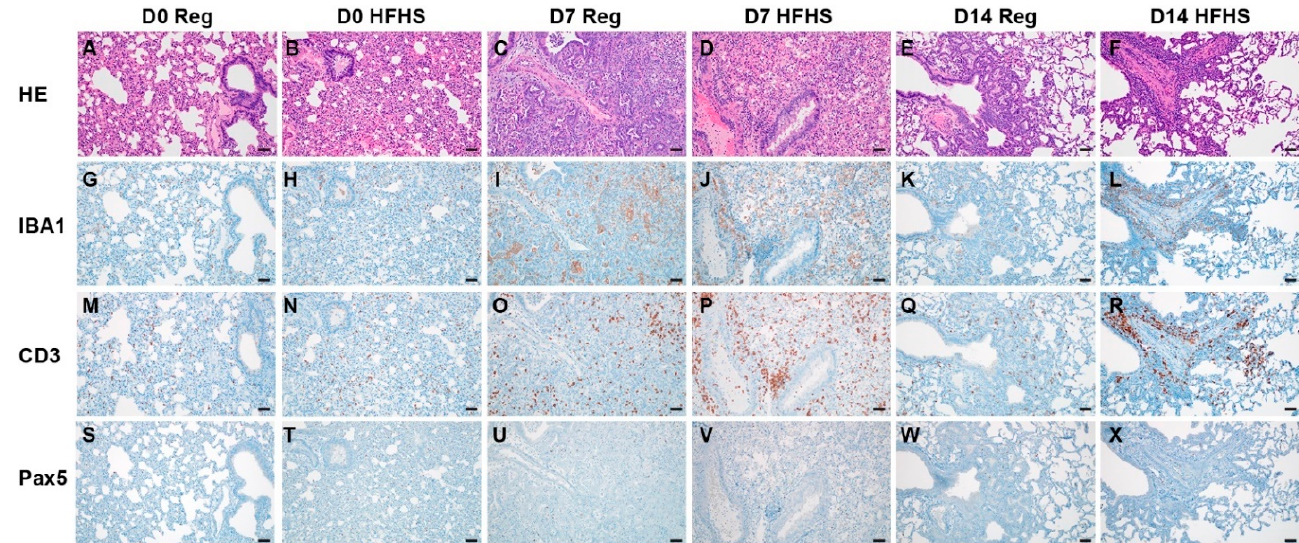
Figure 5. Immune infiltration and in the lung during acute-phase of infection and humoral immunity is not significantly affected by high-fat high-sugar diet. Animals were euthanized at 0, 7, and 14 DPI and the presence of SARS-CoV-2 antigen, T-cells, B-cells and macrophages investigated. ( A , B ) Pre-challenge RD and HFHS diet hamster lungs. ( G , H ) IBA1; ( M , N ) CD3 and ( S , T ) Pax5. ( C , D ) Lungs at 7 DPI. ( I , J ) IBA1; ( O , P ) CD3 and ( U , V ) Pax 5. ( E , F ) Lungs at 14 DPI. ( K , L ) IBA1; ( Q , R ) CD3 and ( W , X ) Pax 5. ( A – F ) HE. All images 200x. Abbreviations: RD = regular diet; HFHS = high-fat high-sugar; DPI = days post